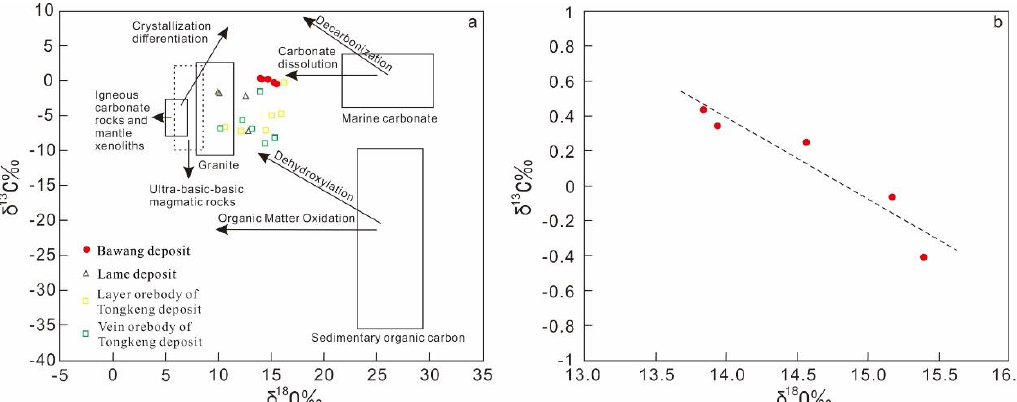
Figure 8. The δ 13 C–δ 18 O diagram of calcites from the main deposit in the Nandan-Hechi metallogenic belt ( a ) (modified after Liu et al. [64], the data from Liu [70], Tan et al. [71], and Ding et al. [72]) and the negatively correlated of δ 13 C and δ 18 O ( b ).